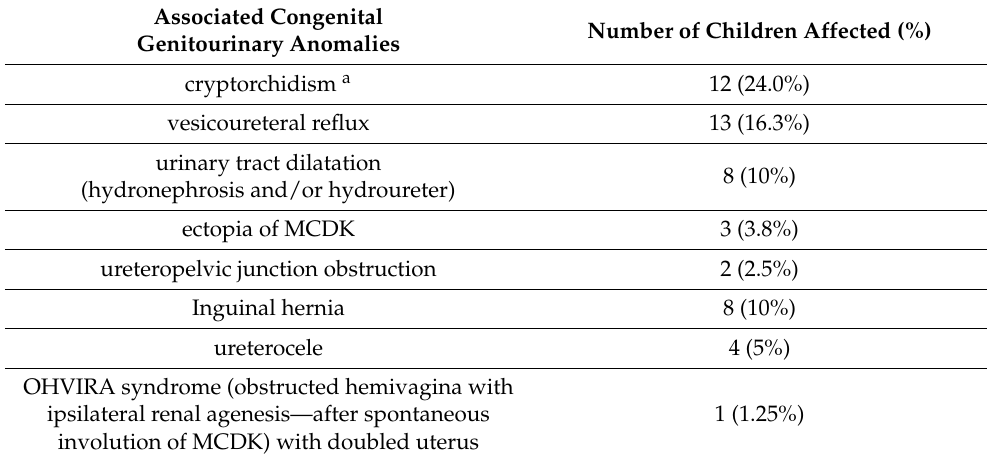
Table 1. Most common associated congenital genitourinary anomalies in children with multicystic dysplastic kidney